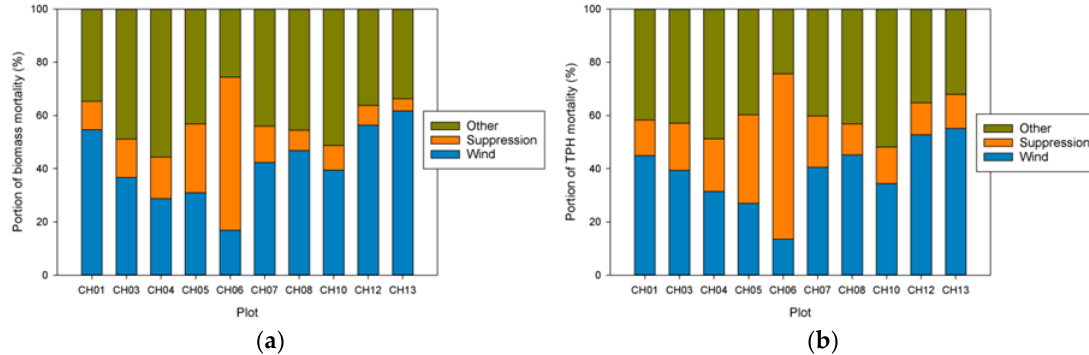
Figure 8. Tree mortality in terms of biomass ( a ) and trees per ha ( b ) resulting from wind, suppression and other or unknown causes over the entire measurement interval (1935–2013) in each permanent plot.